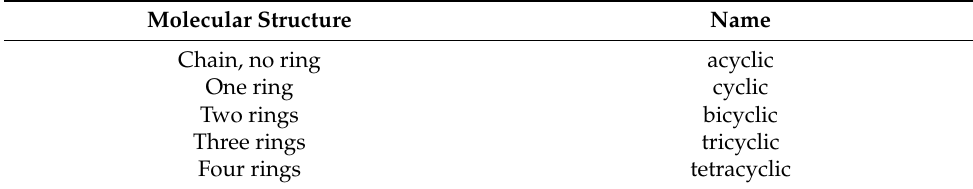
Table 2. Sub-classification of